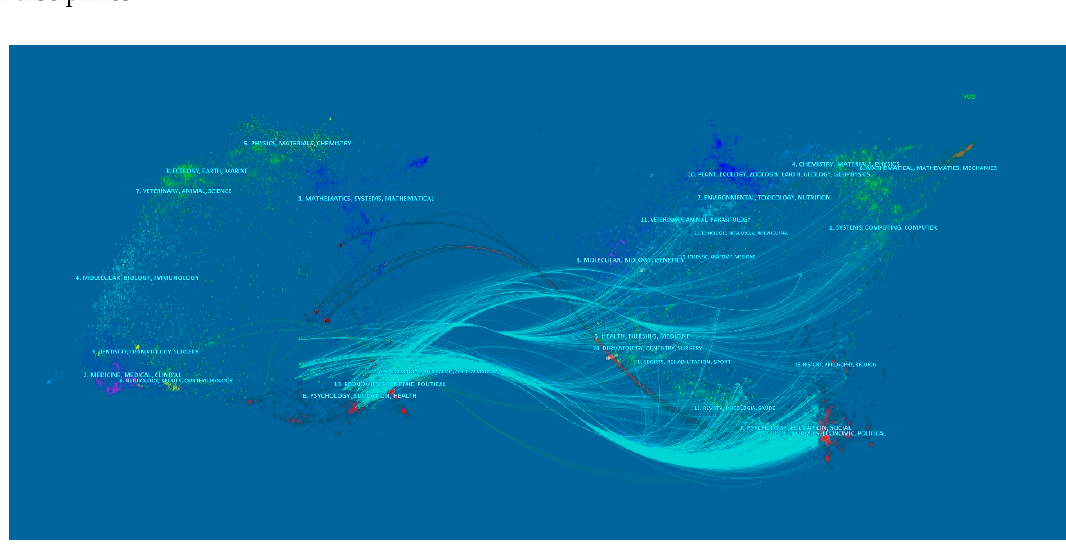
Figure 1. The location of second language acquisition in the knowledge domain.